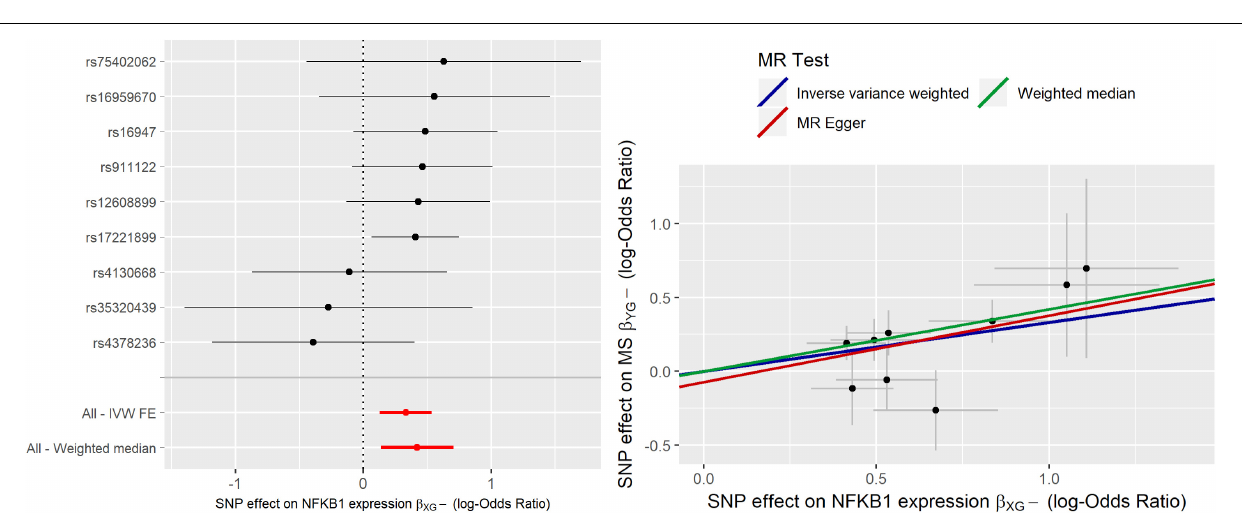
FIGURE 4 | Forest plot and Scatter plot of causal estimates of NFKB1 expression in cerebellum (CRBL) on